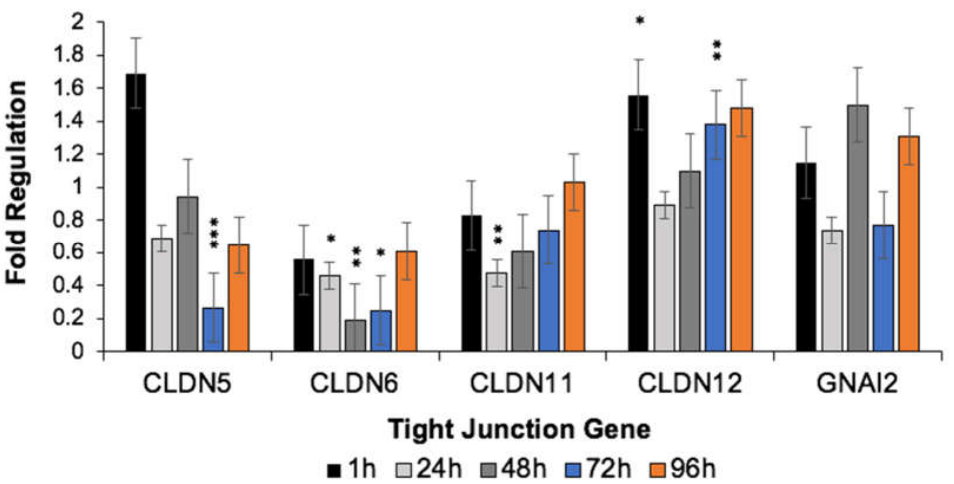
Figure 6. Cldn5 , Cldn6 , Cldn11 , Cldn12 and Gnai2 displayed the greatest change in expression